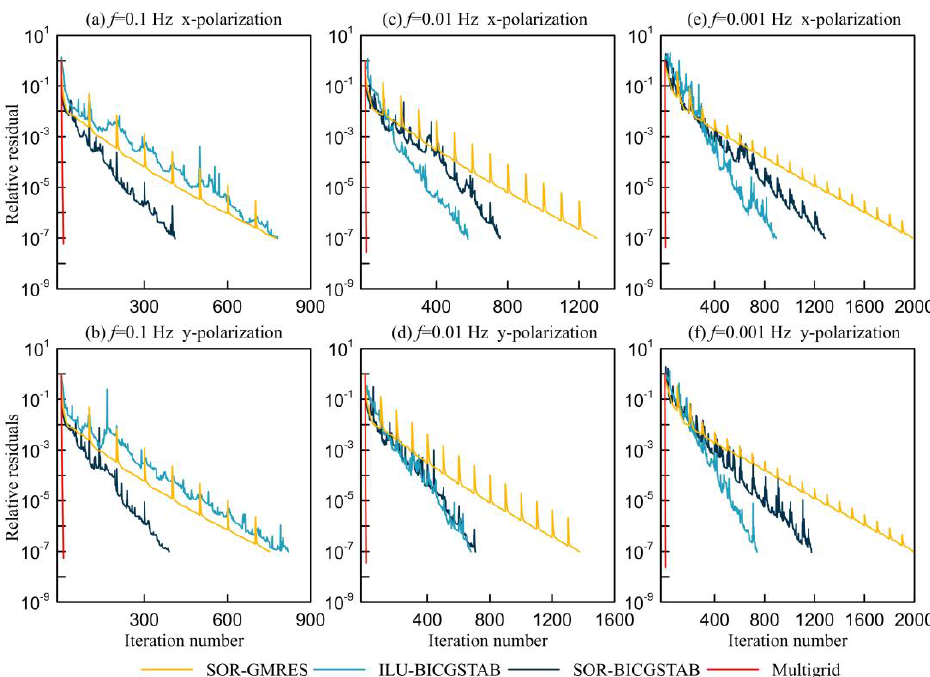
Figure 16. Convergence curves of SOR-GMRES, ILU-BICGSTAB, SOR-BICGSTAB and our MG algorithm for the modified SEG/EAEG salt dome model at 0.1, 0.01 and 0.001 Hz. The computation is conducted on the grid size of 128 × 128 × 88, with a DoF of 4,403,544. Table 4. Computational performance of SOR-GMRES, ILU-BICGSTAB, SOR-BICGSTAB and our MG algorithm for the modified SEG/EAEG salt dome model in x , y -polarization modes at 0.1, 0.01 and 0.001